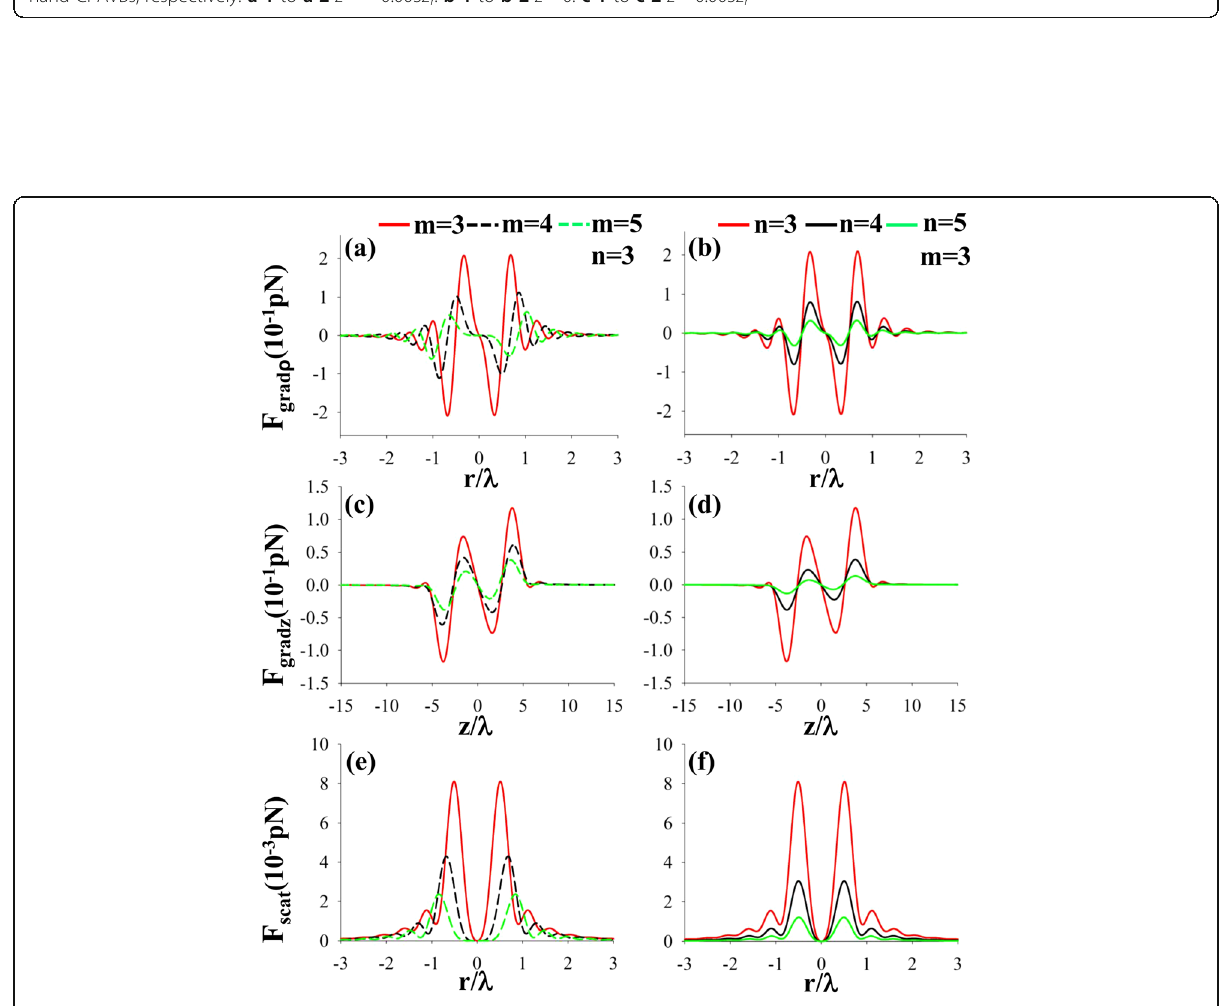
Fig. 5 a – f The radial, longitudinal gradient forces and scattering forces of a left-hand CPAVB after tight focusing on a low refraction index particle n p =